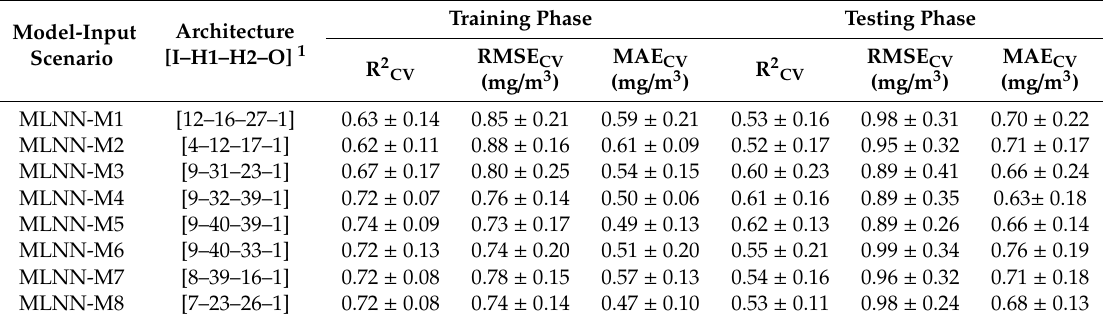
Table 4. Performance of Chl-a estimation from MLNN models based on eight di ff erent input scenarios obtained in 5-fold cross validation.